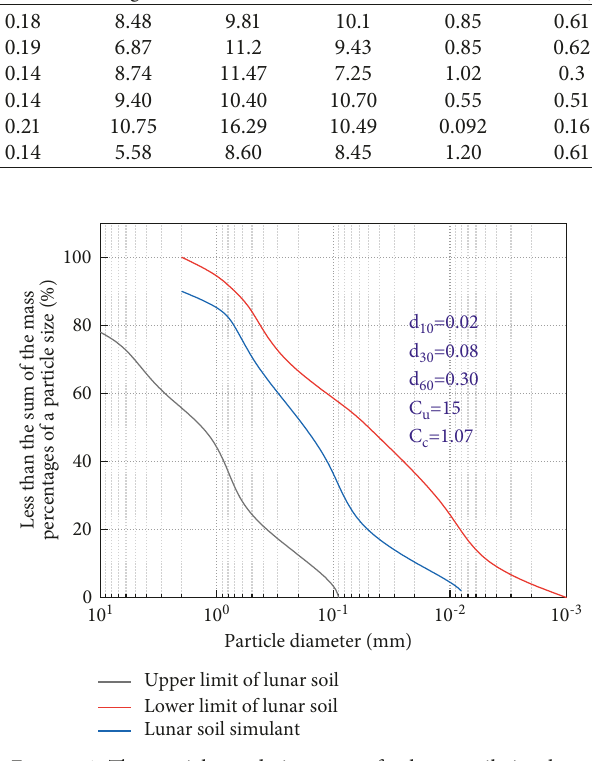
Figure 4: The particle gradation curve for lunar soil simulant.